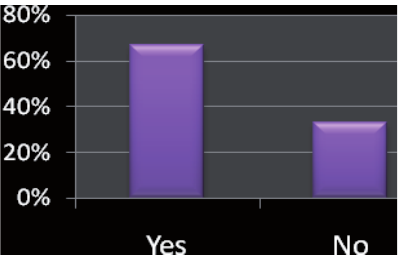
Fig.3.1. Knowledge about the Fig.3.2. The information that educators psychomotor education. give about the normal